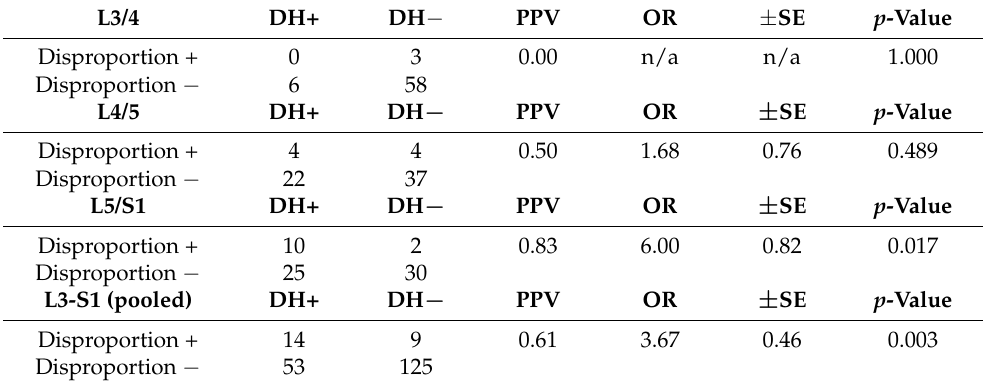
Table 3. The status of disproportion and DH at each disc level.